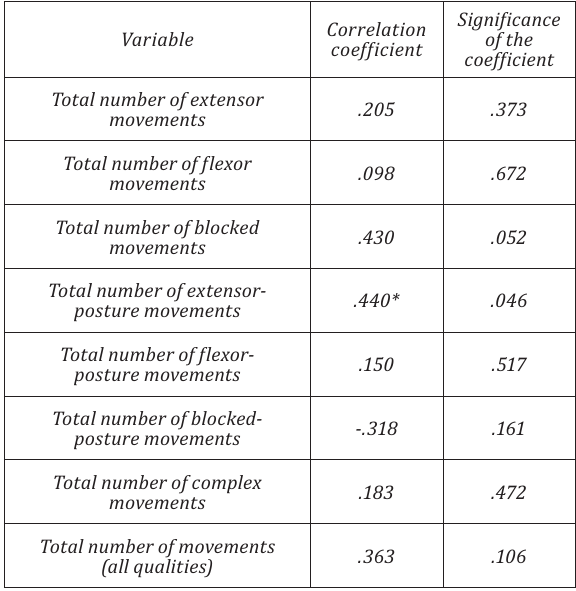
Table 8. The values of Spearman’s rho between the shading variable and movement quality variables in the group of